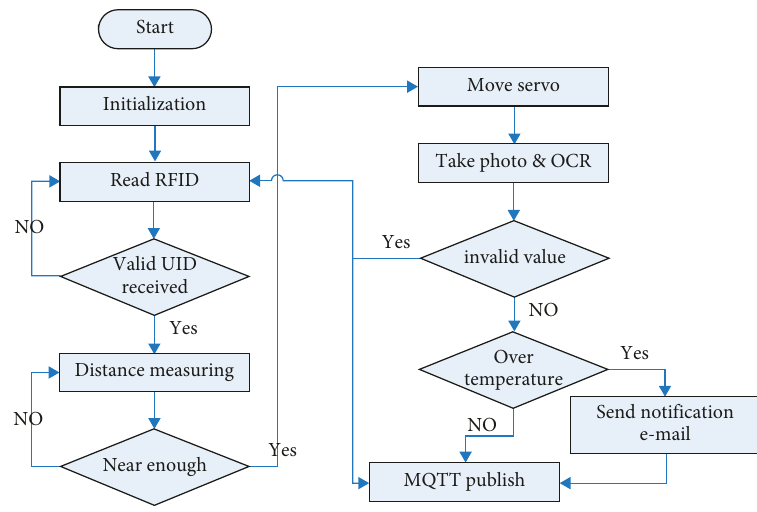
Figure 6: Flowchart of autothermometer